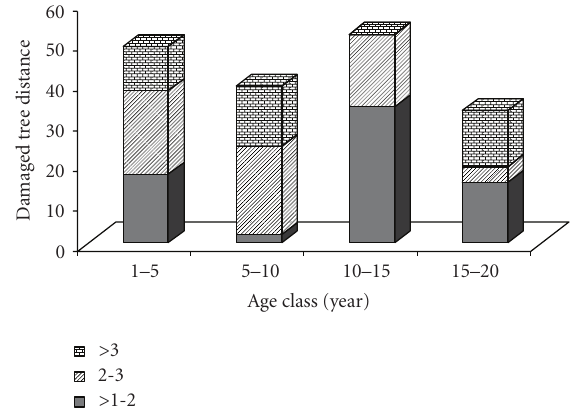
Figure 2: Distribution of DBH class of all trees in time since